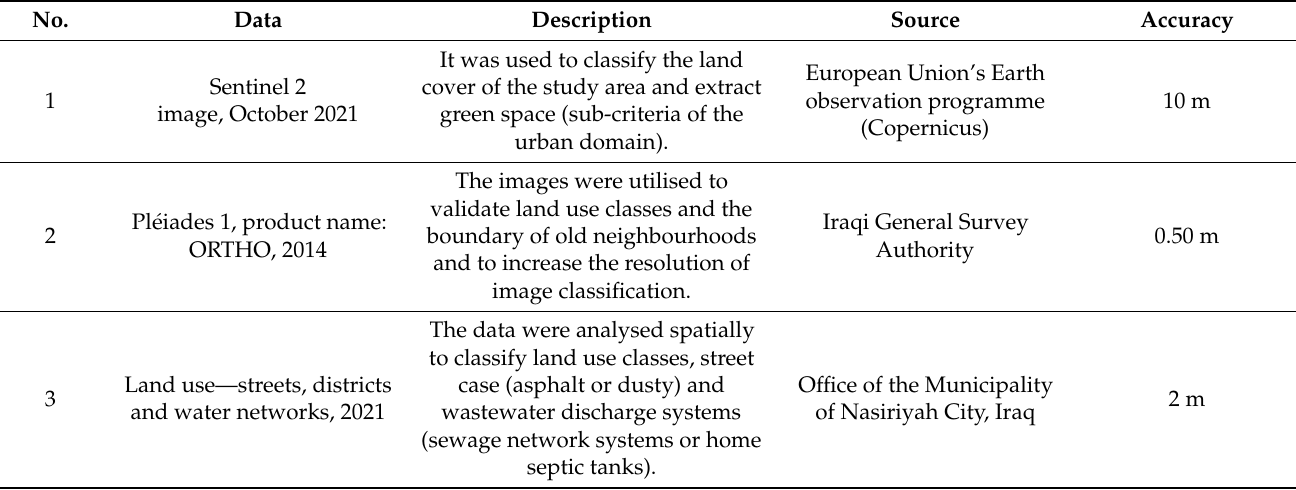
Figure 2. Khamisiyah site and boundary of Nasiriyah City. The three pictures on the right show a close-up view of the Khamisiyah site.